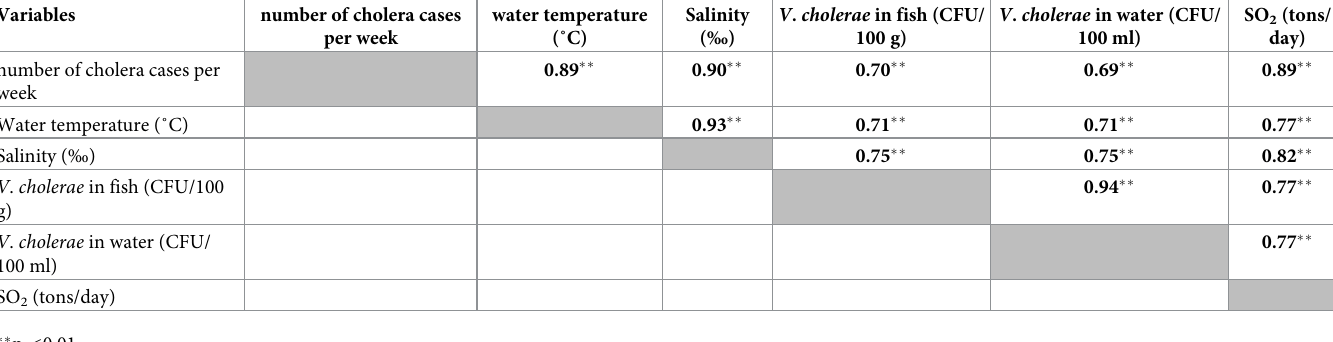
Table 7. Pearson correlation coefficients between logarithmic transformation of observed cholera cases in the Katana health zone. physico-chemical characteristics of lake Kivu. and the concentration of V. cholerae in lake water and fish over the 2016–2017 period (n = 48 sampled